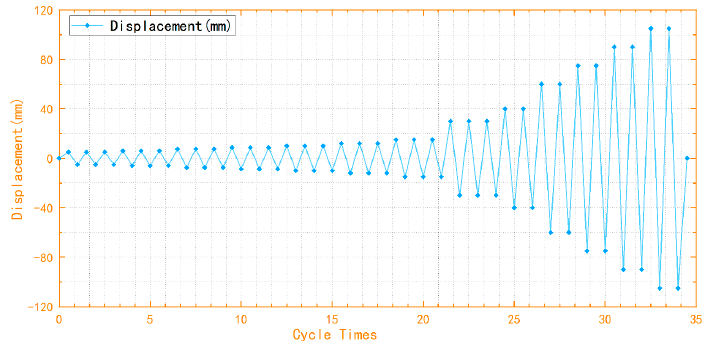
Figure 7. Loading